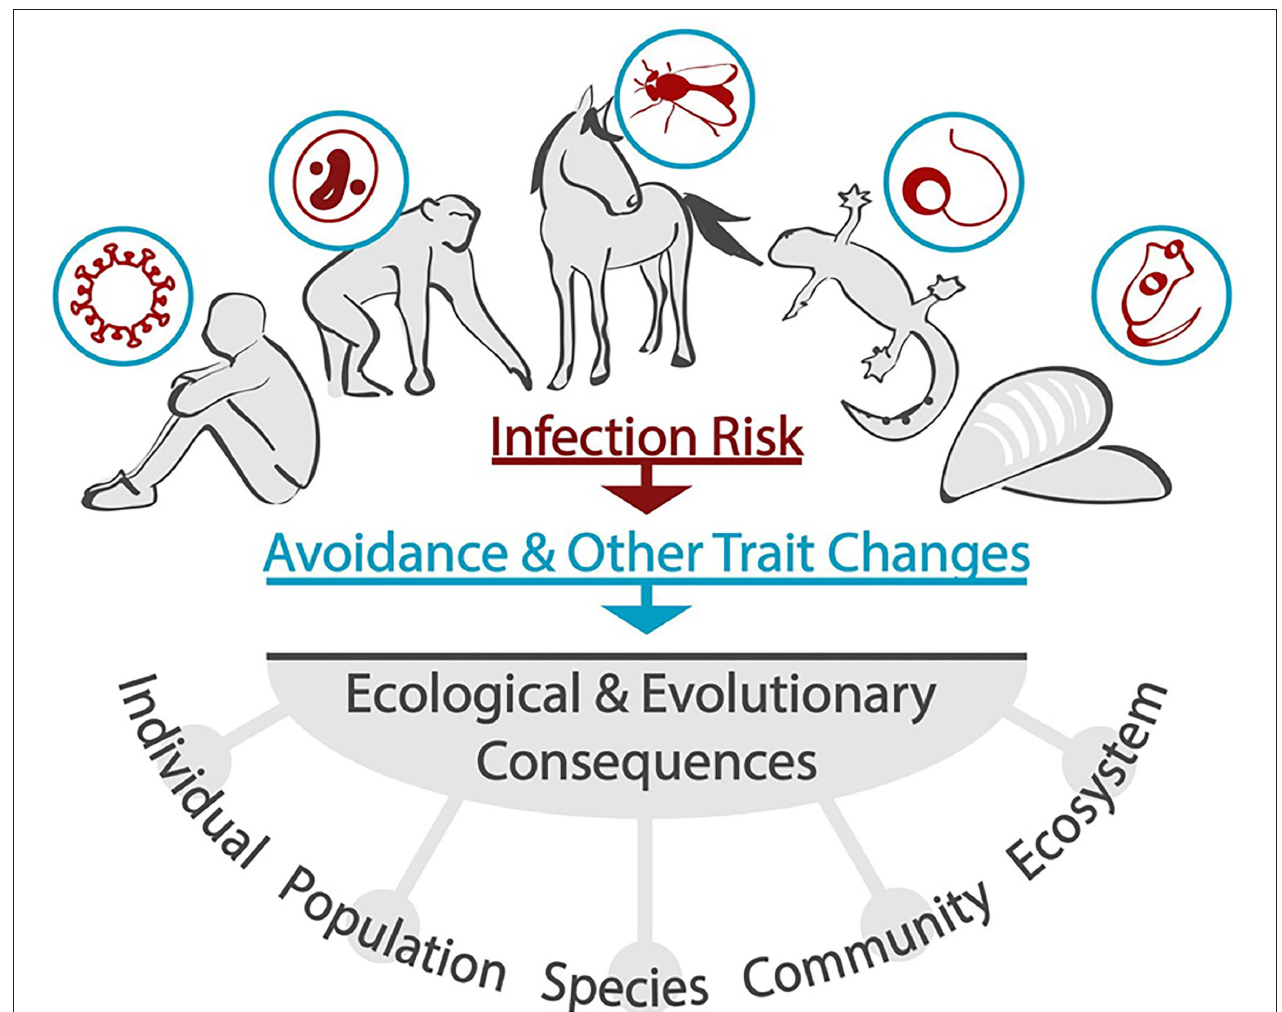
FIGURE 1 | Across diverse hosts and parasites, infection risk generates avoidance via changes in behavior and other traits. Papers in this special topic provide insight into the mechanisms of detection, the range of avoidance behaviors, trade-offs associated with reducing infection risk, and the ecological and evolutionary consequences of avoiding infection. As demonstrated by Selbach and Mouritsen, consequences can occur at a range of scales, from individual (e.g., reduced feeding) to ecosystem (e.g., altered nutrient cycling). Effects at the individual and population levels can also exert selective pressure, acting as feedback on avoidance behaviors to increase or maintain these for any given host-parasite